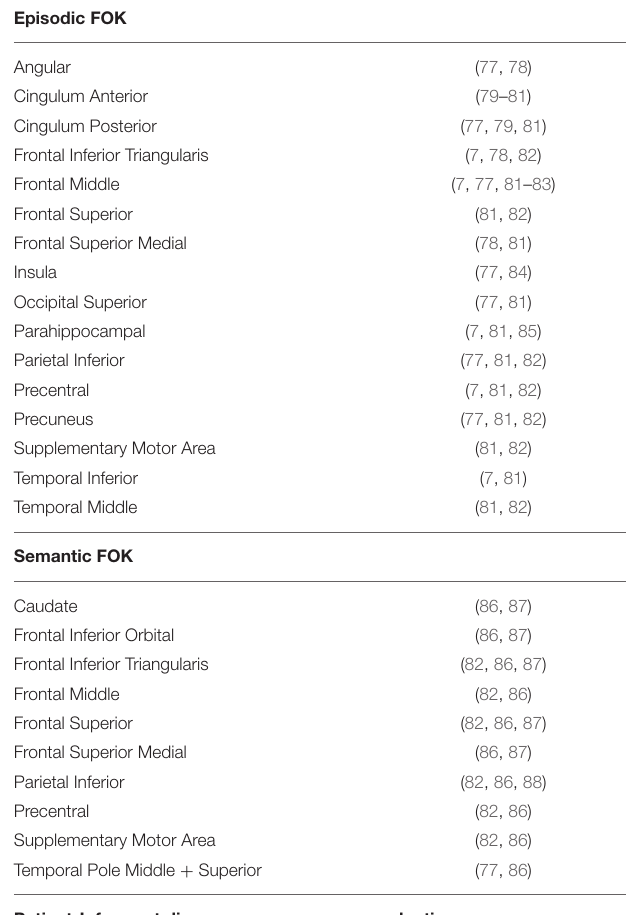
TABLE 2 | A priori AAL ROIs for correlations between self-awareness measures and brain metabolism and